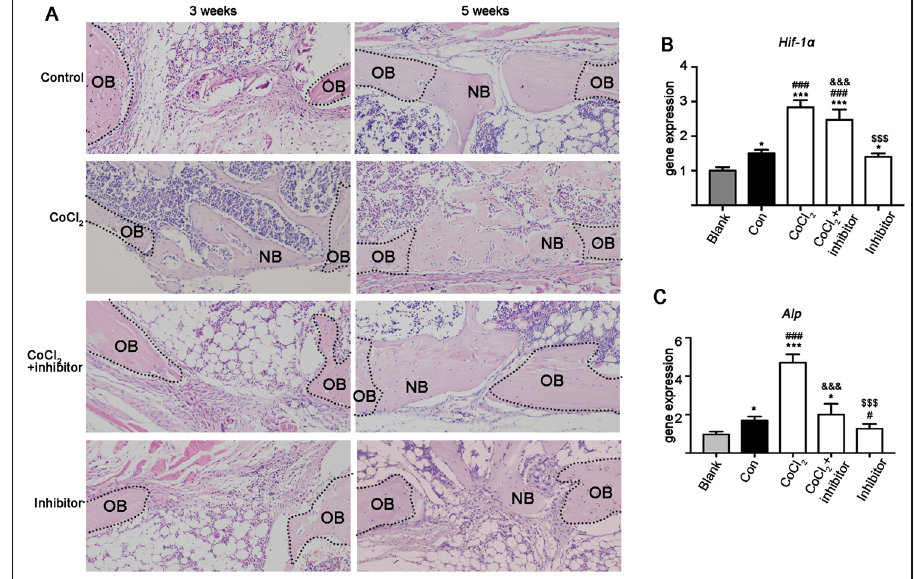
Representative images of mouse femoral bone defect histological section (H & E staining). b and c – Hif-1 α and Alp gene expression in mouse femoral bone defects on day 7. Data of quantitative analysis are the means ± SD, n = 5. Significant effect of the treatment compared to the blank group: * p < 0.05 and *** p < 0.001; the control group: # p < 0.05, ### p < 0.001; the CoCl 2 group: &&& p < 0.001; and the CoCl 2 + inhibitor group: $$$ p < 0.001. Inhibitor: STAT3 inhibitor, OB: original bone, NB: newly formed bone, Red arrow: